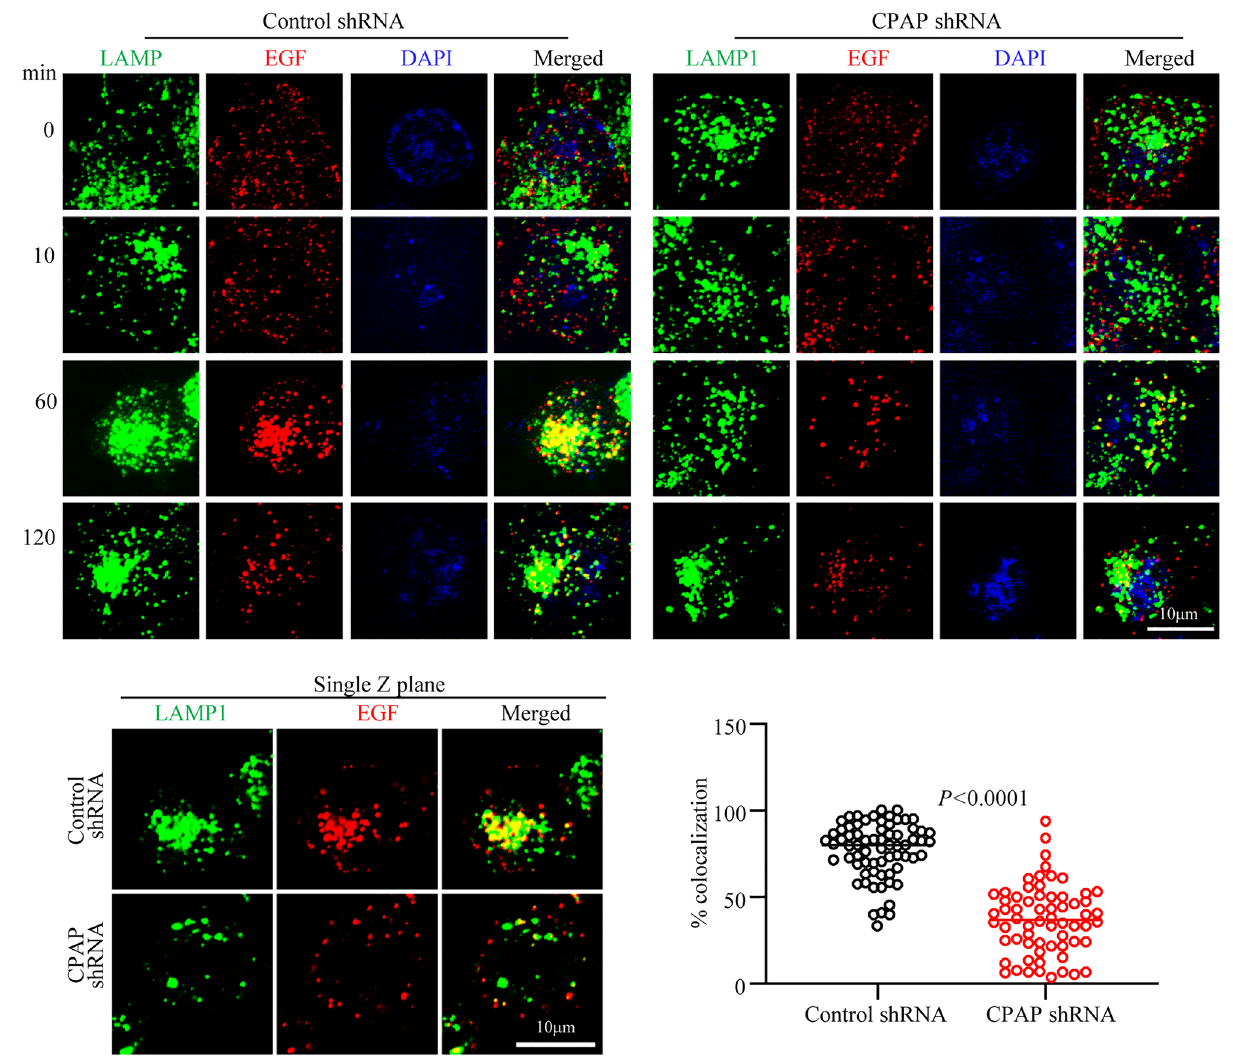
Figure 6. CPAP depletion results in defective targeting of internalized cell surface receptor to the lysosome. HeLa cells expressing control-shRNA or CPAP-shRNA were incubated with Alexa fluor 555-conjugated EGF ligand and left on ice for 1 h. Cells were washed with serum free media and transferred to 37 °C to initiate receptor internalization. Cells were fixed at indicated time-points, permeabilized and stained for LAMP1 to mark lysosomes, and images were acquired as Z-stacks using Zeiss 880 microscope. Maximum projection images of cells harvested at different time-points (left panel), and single Z-plane of relevant images (upper right panel) and percentage of EGF + vesicular structures that co-localize with LAMP1 + structures at 60 min time-point (lower right panel) from four independent experiments combined are shown. Vesicular structures of a single Z-plane were counted for each cell area. Supplemental Fig. 9B shows LAMP1 staining fluorescence intensity of cell areas of multiple experiments. All images were processed using ImageJ software version 1.53 (https:// imagej. nih. gov/ ij/). P -value by unpaired t -test. GraphPad Prism software version 9 (https:// www. graph pad. com/ scien tific- softw are/ prism/) was used for determining P